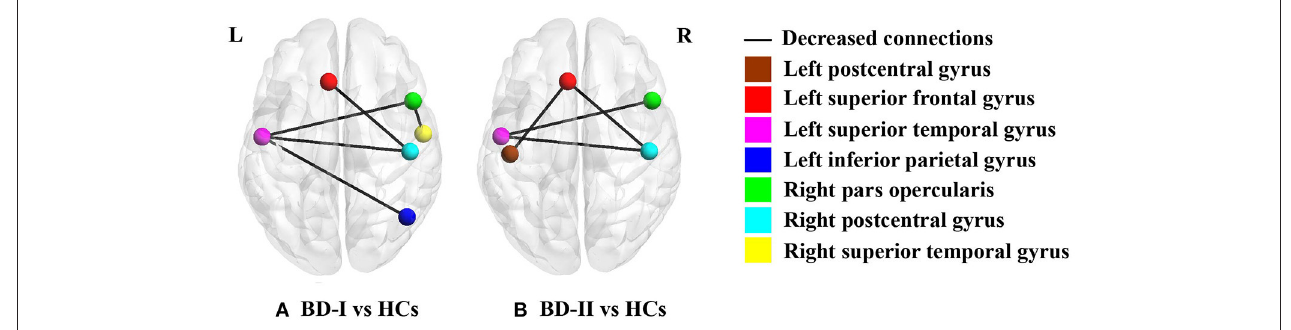
FIGURE 1 | Significant between-group differences of cortical structural covariance. Brain regions are expressed with colored balls, and decreased structural covariance connections between brain regions are represented by solid black lines. (A) BD-I group presents significantly decreased structural covariance connections relative to HCs after FDR correction; (B) BD-II group shows significantly declined structural covariance connections compared with HCs after FDR correction. BD-I, bipolar disorder type I; BD-II, bipolar disorder type II; HCs, healthy subject controls.